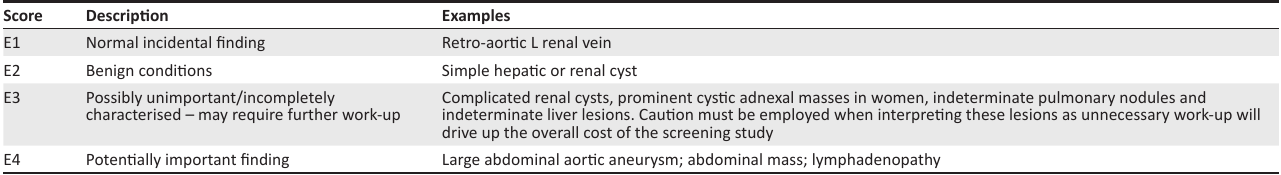
TABLE 4: Extracolonic classifications † .